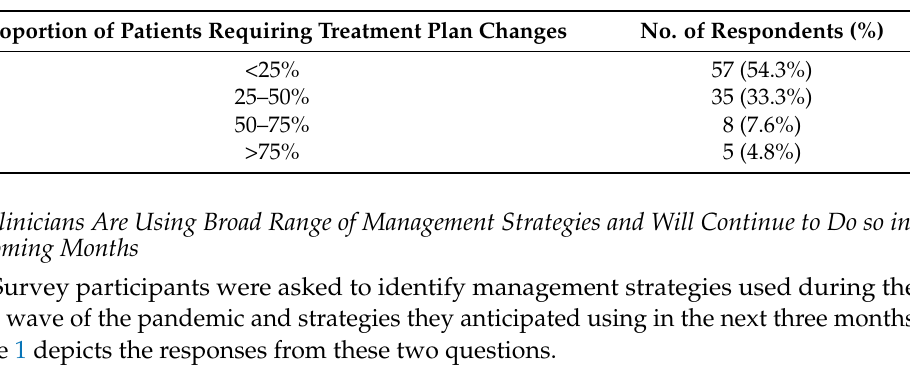
Table 3. Proportion of patients requiring treatment plan modifications between April and June 2020 due to the COVID-19